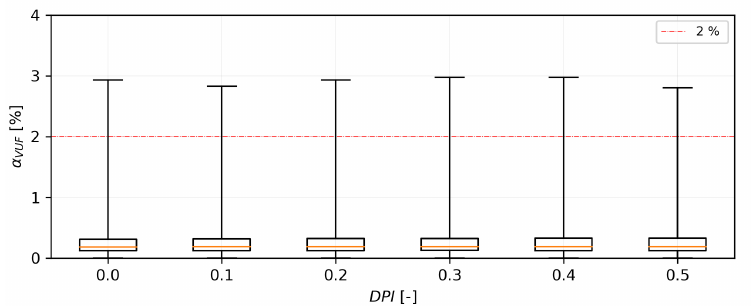
Figure 10. Results of voltage unbalance for V0